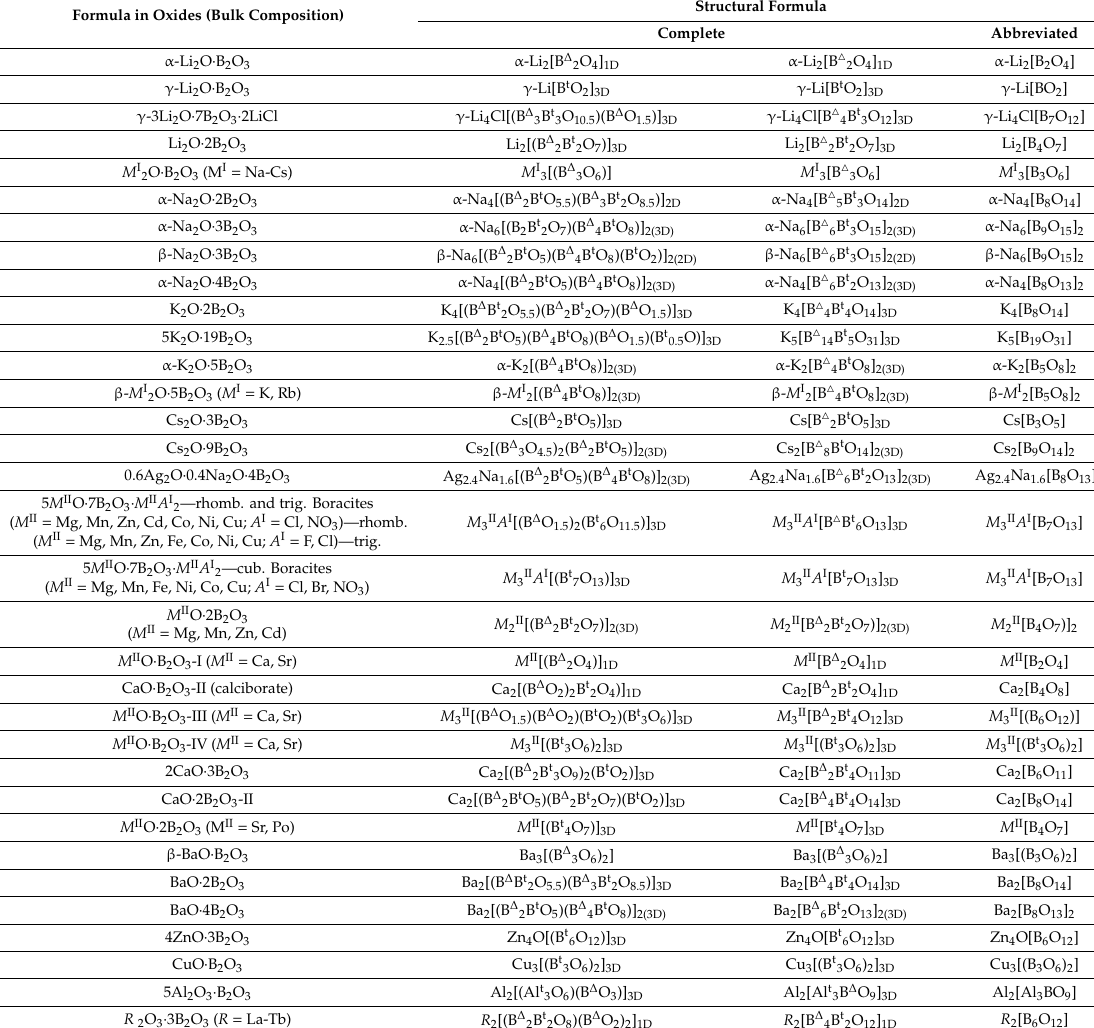
Table 4. Structural formulas of monocationic